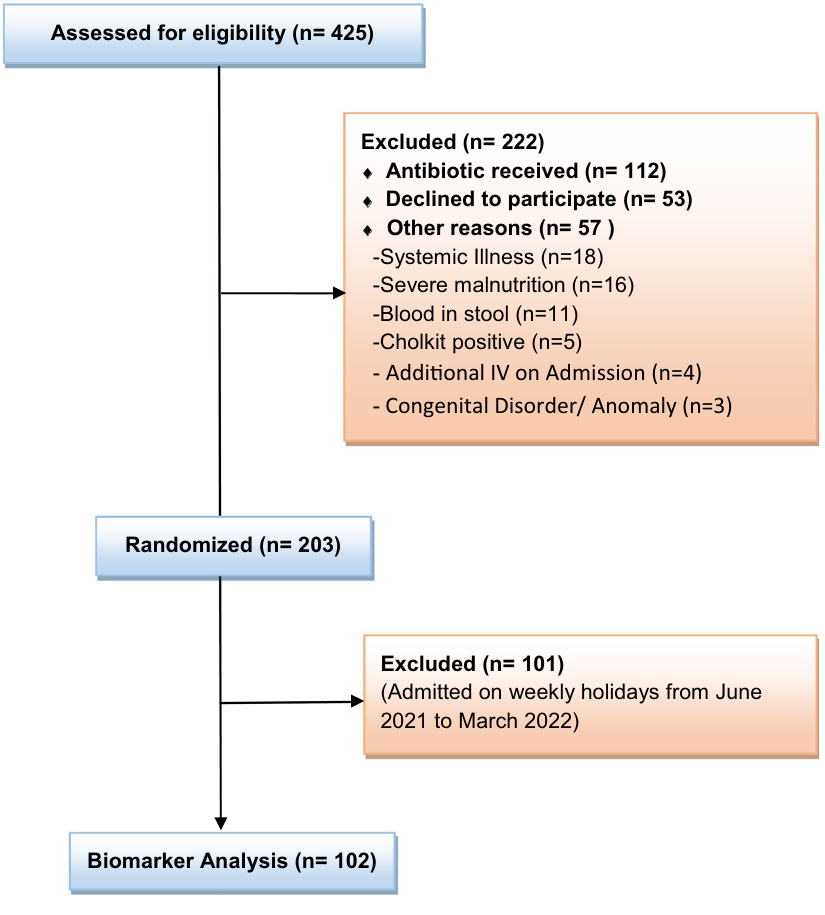
Figure 1. Study flow